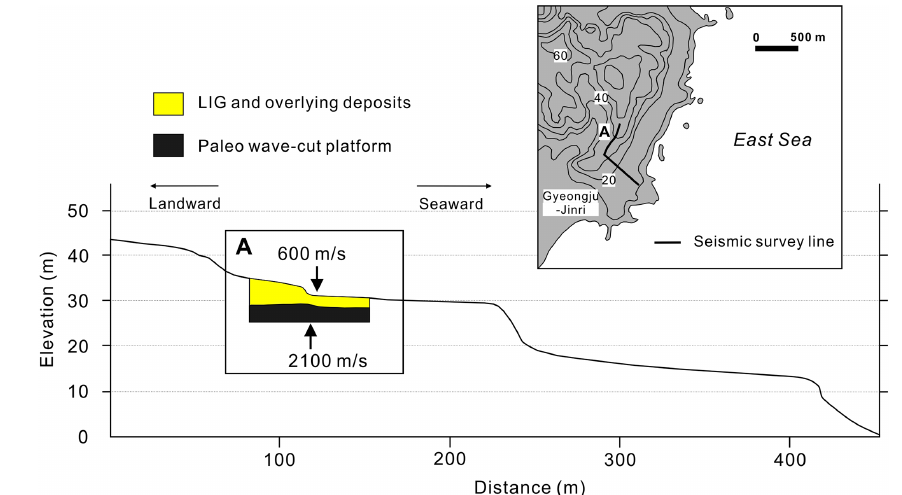
Figure 5. Seismic interpretation and calculated elevation of the buried LIG wave-cut platform at subsite Jinri of the Gyeongju area, based on seismic velocities between the overlying deposits and a paleo-wave-cut platform (modified after Kim et al., 2007a). The topographic contour interval is 10m. For location, see Fig. 2.